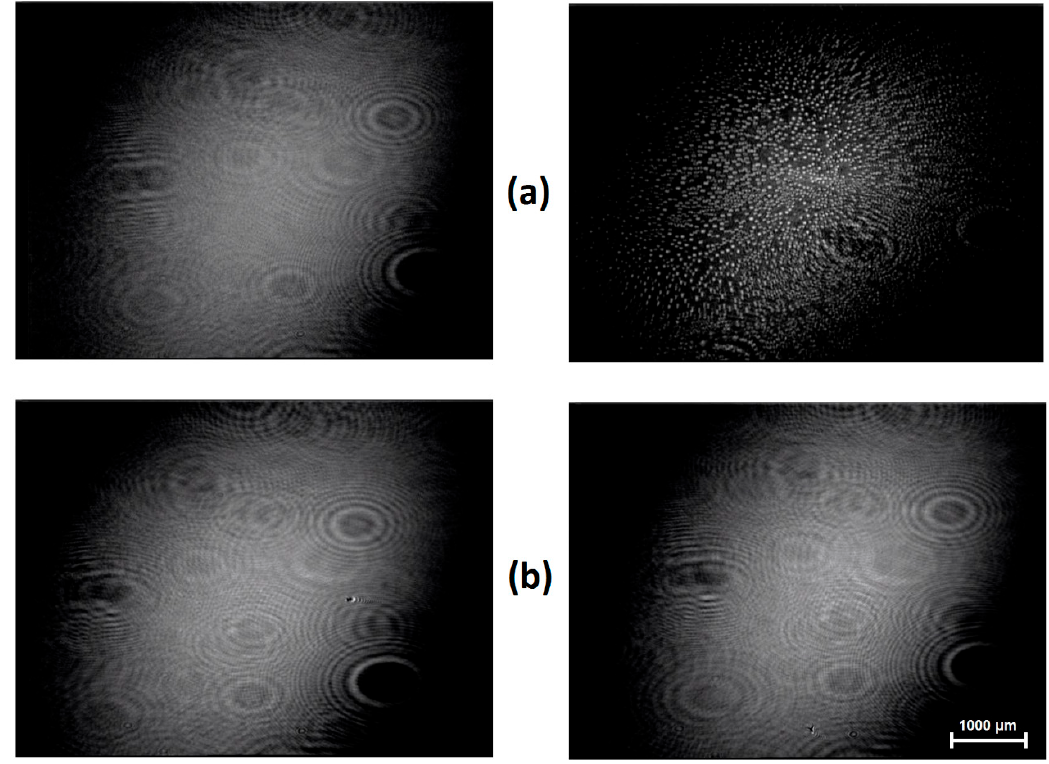
Figure 3. Brewster angle microscopy (BAM) images of ( a ) Ethoxy-PPE at π of 2 mN / m, A ~ 96 Å 2 (left) and 7 mN / m, A ~ 63 Å 2 (right), and ( b ) Methyl-PPE- co -decadiene at π of 2 mN / m, A ~ 84 Å 2 (left) and 9 mN / m, A ~ 47 Å 2 (right). All images were captured with a compression rate of 50 Å 2 / (molecule min). The image size is 4.8 × 6.4 mm 2 .